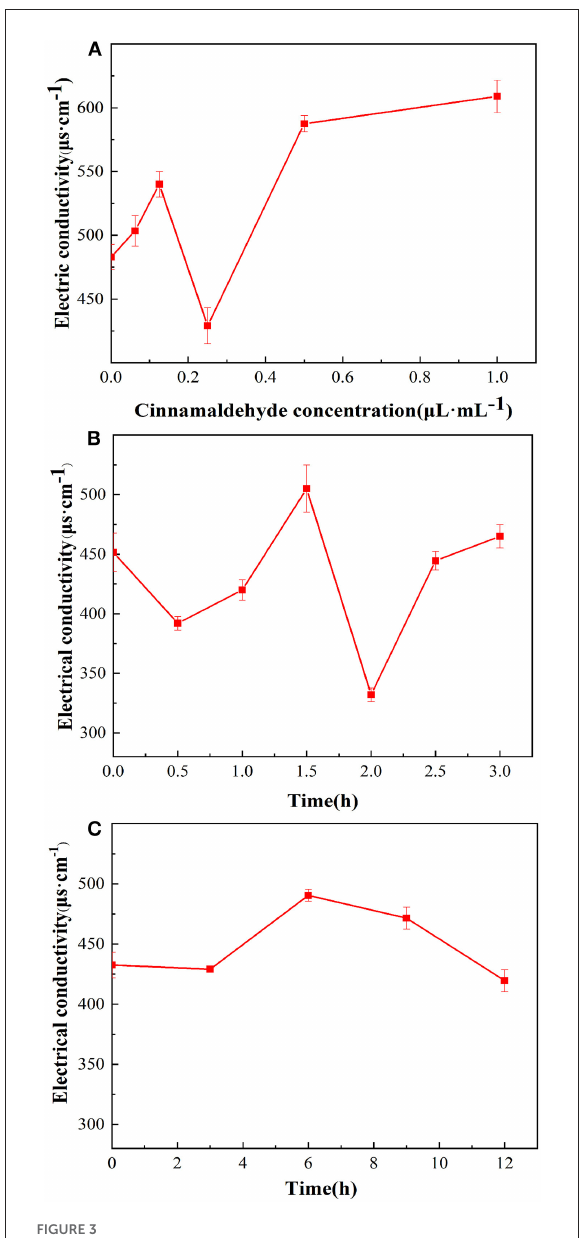
FIGURE3 Effect of cinnamaldehyde vapor-phase fumigation of E. coli on its electrical conductivity [ (A) cinnamaldehyde concentration; (B) fumigation time (0–3h); (C) fumigation time (0–12h)].